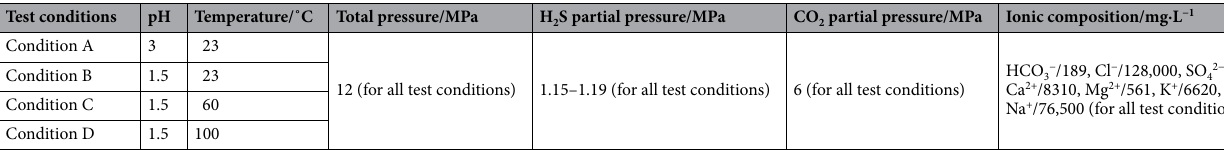
Table 5. Test conditions of electrochemical measurements and corrosion resistance evaluation.